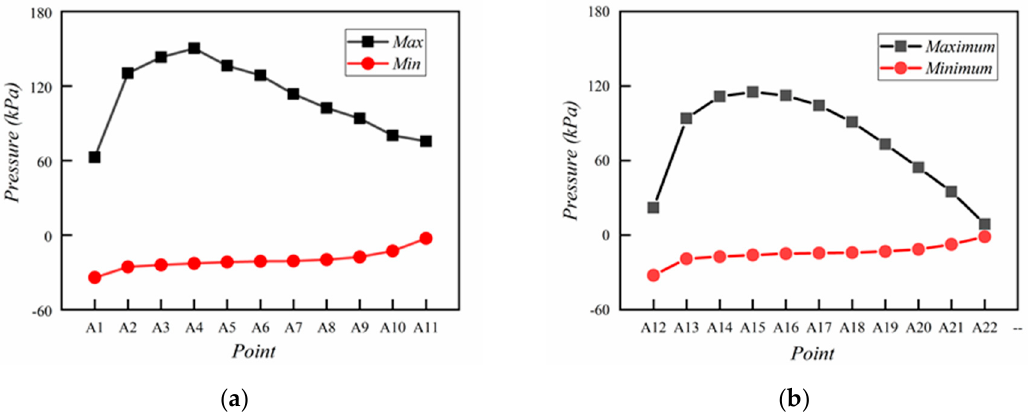
Figure 21. ( a ) The spatial distribution of pressure peaks and valleys at Points A1–A11. ( b ) The spatial distribution of pressure peaks and valleys at Points A12–A22.